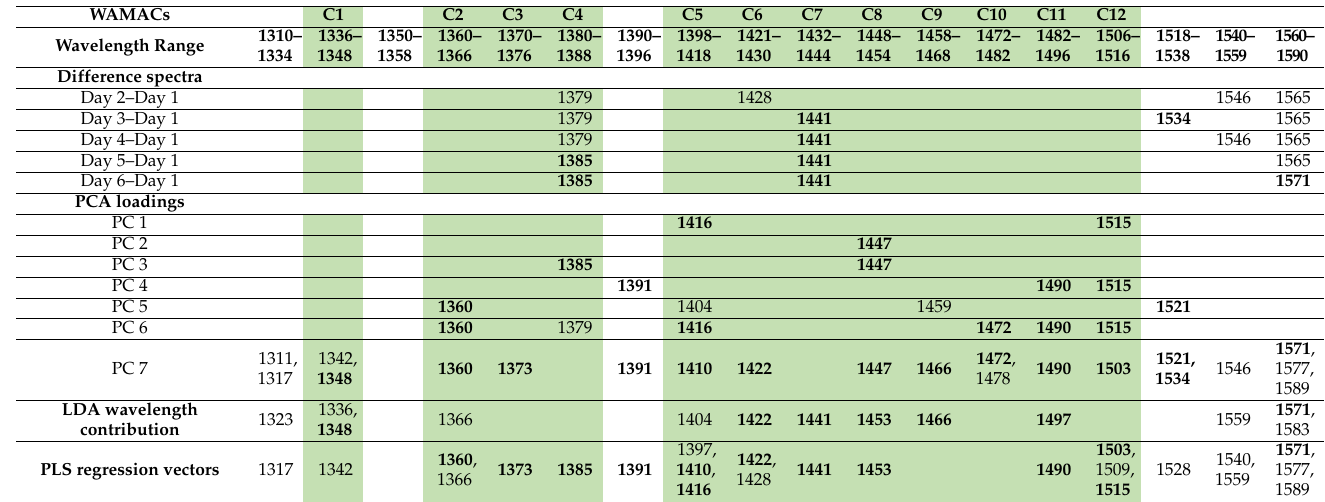
Table 4. Prominent wavelengths for statistical modeling on the data of outer